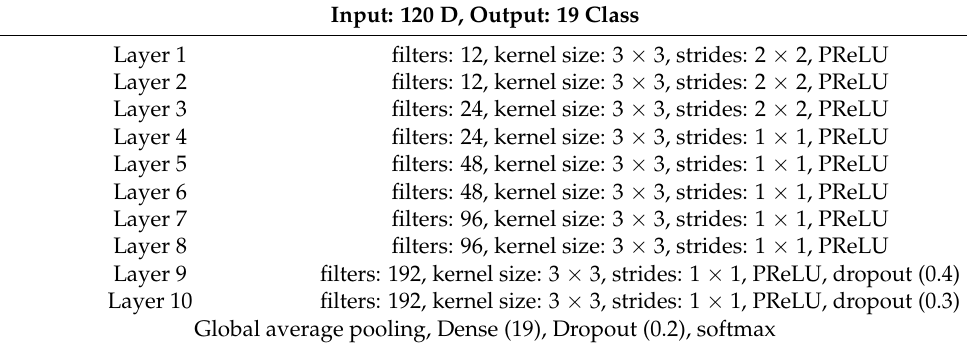
Table A3. Structure of the CNN–MFCC system.